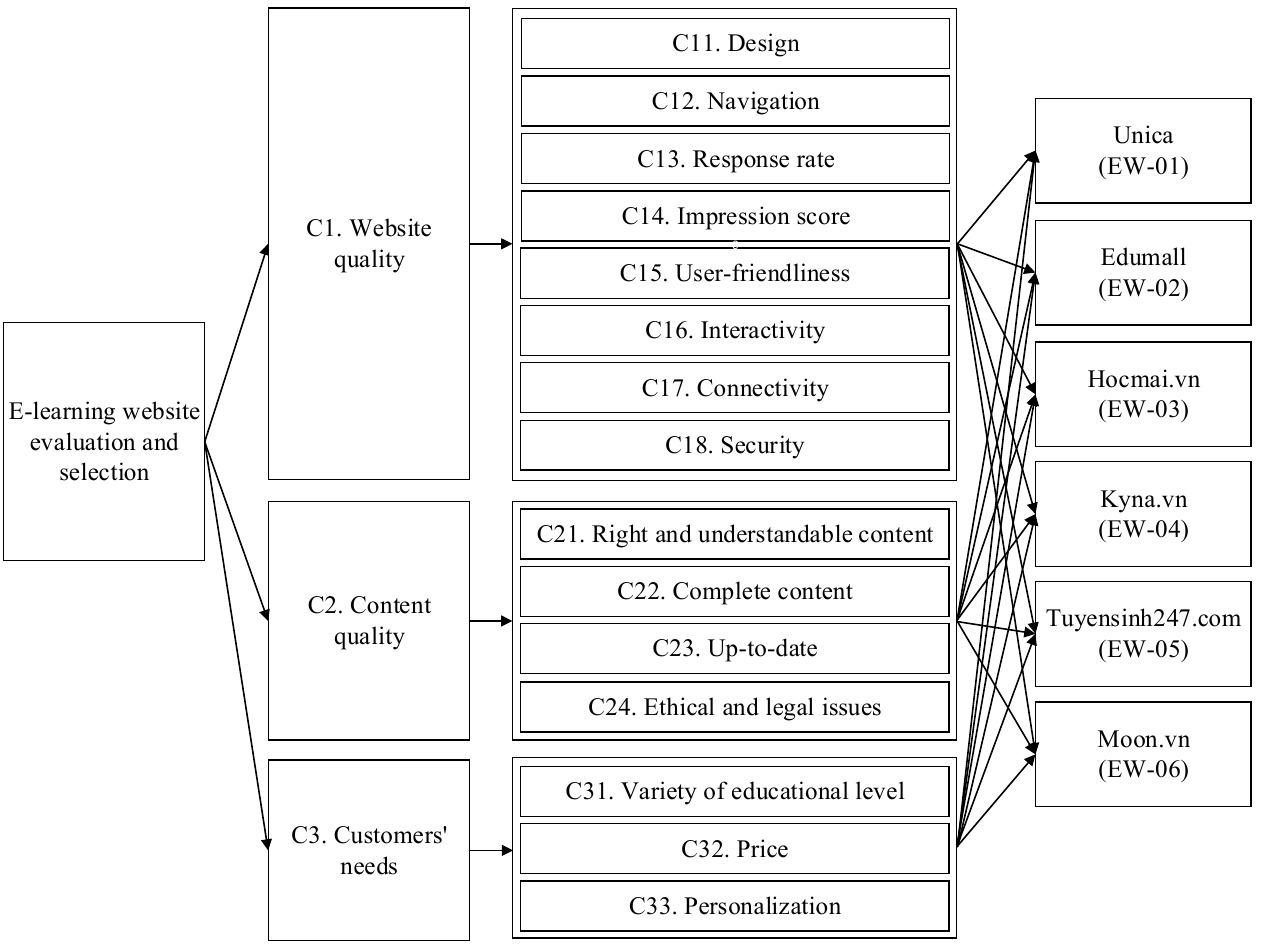
Figure 4. The decision tree for evaluation of e-learning websites.